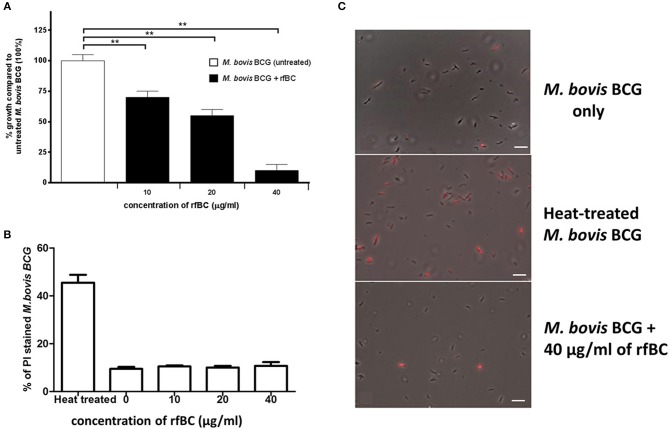
rfBC has a direct bacteriostatic effect on the growth of M. bovis BCG. (A)
M. bovis BCG cells were grown in the presence of 10, 20, and 40 μg/ml of rfBC to assess any effect on bacterial growth. Untreated M. bovis BCG was used as a negative control. Bacterial colony forming units were obtained and counted. The percentage difference in growth for each rfBC concentration was calculated with respect to untreated M. bovis BCG as 100% (corresponding to 6 × 104 cells). Bars denote ± 2 standard deviations. The experiment was performed in triplicate for each rfBC concentration and was repeated three times. A one-way ANOVA test was performed to determine significant differences in growth from untreated M. bovis BCG vs. treatment with rfBC at the different concentrations. All comparisons were significant (**p ≤ 0.01). (B) Propidium iodide (PI) assay was used to assess any bacterial cell lysis as a result of incubation with rfBC. M. bovis BCG cells were incubated for 2 h with 0, 10, 20, and 40 μg/ml of rfBC. Heat-treated M. bovis BCG was used as a positive control for cell lysis. PI was added, and cells spotted onto glass slides and analyzed using fluorescence microscopy. Fluorescent M. bovis BCG cells were counted from each sample and the total percentage of PI stained cells calculated for each rfBC concentration. Bars denote ± 2 standard deviations. The assay was performed in triplicate. A one-way ANOVA test was performed to determine significant differences in PI staining from heat-treated M. bovis BCG vs. treatment with rfBC at the different concentrations. All comparisons were significant (p ≤ 0.05), unless where shown (ns, not significant; p > 0.05). (C) Qualitative data showing PI staining of M. bovis BCG at 40 μg/ml of rfBC, compared to heat-treated M. bovis BCG and untreated M. bovis BCG. Bar scale 10 μm.